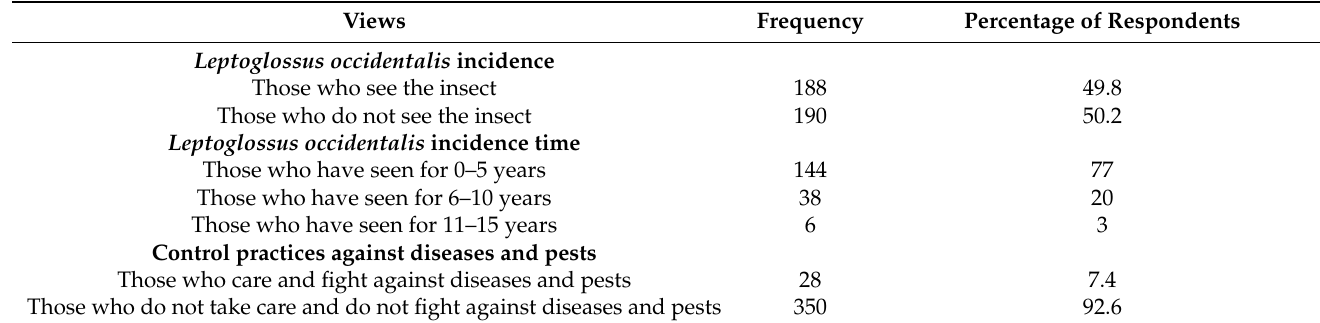
Table 8. Farmers’ views on L. occidentalis and the fight against diseases and pests.